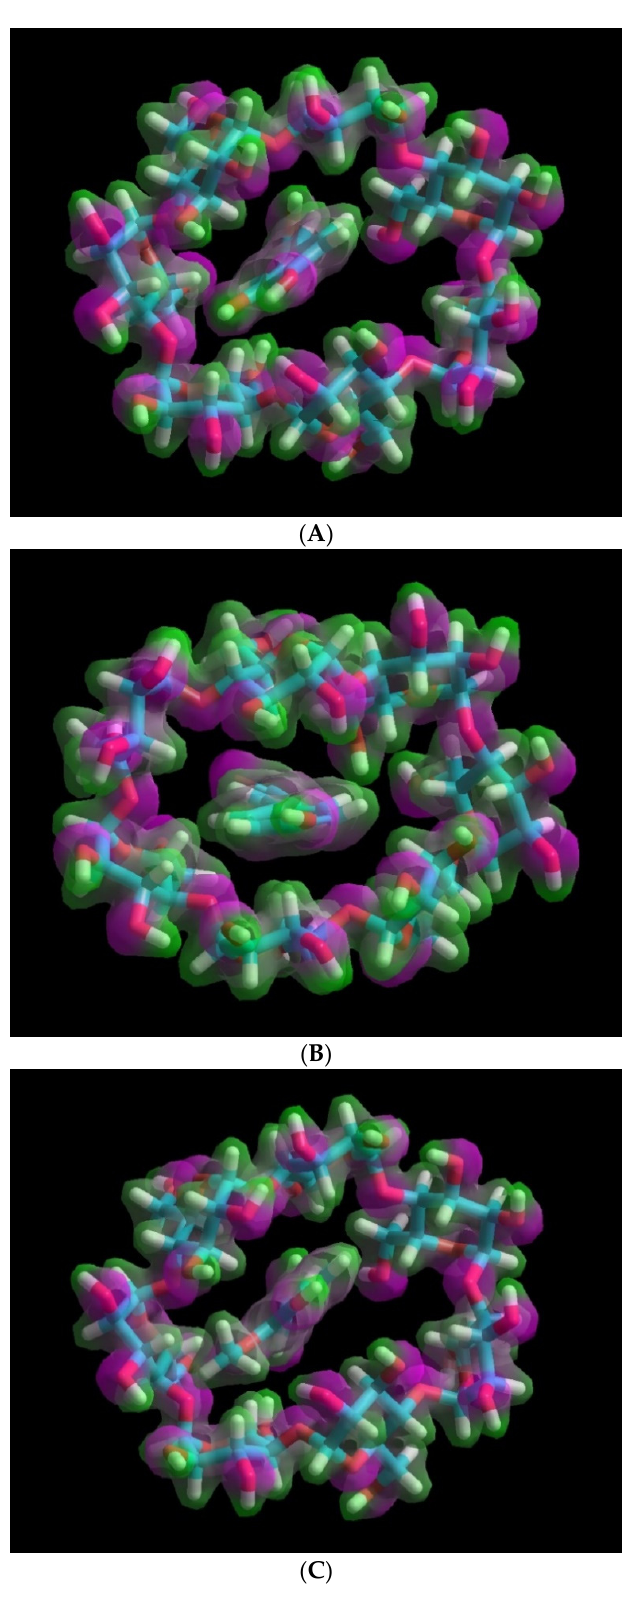
Figure 4. Electrostatic surface potential (ESP) representation and phenolic acid positions within the CD: ( A ) caffeic acid and β ‐ cyclodextrin, ( B ) p ‐ coumaric acid and β ‐ cyclodextrin, ( C ) trans ‐ ferulic acid and β ‐ cyclodextrin.